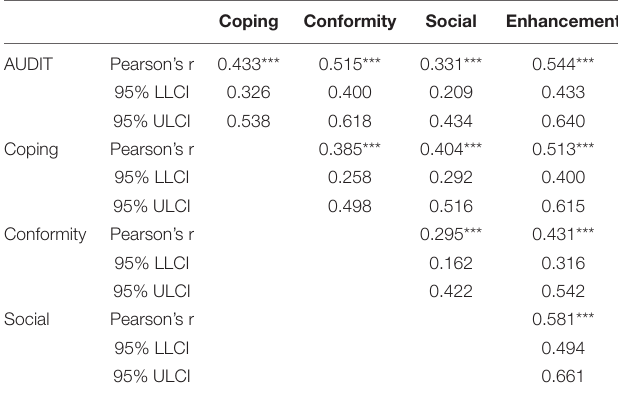
TABLE 6 | Pearson’s correlation with bootstrapping of AUDIT and motives ( N =